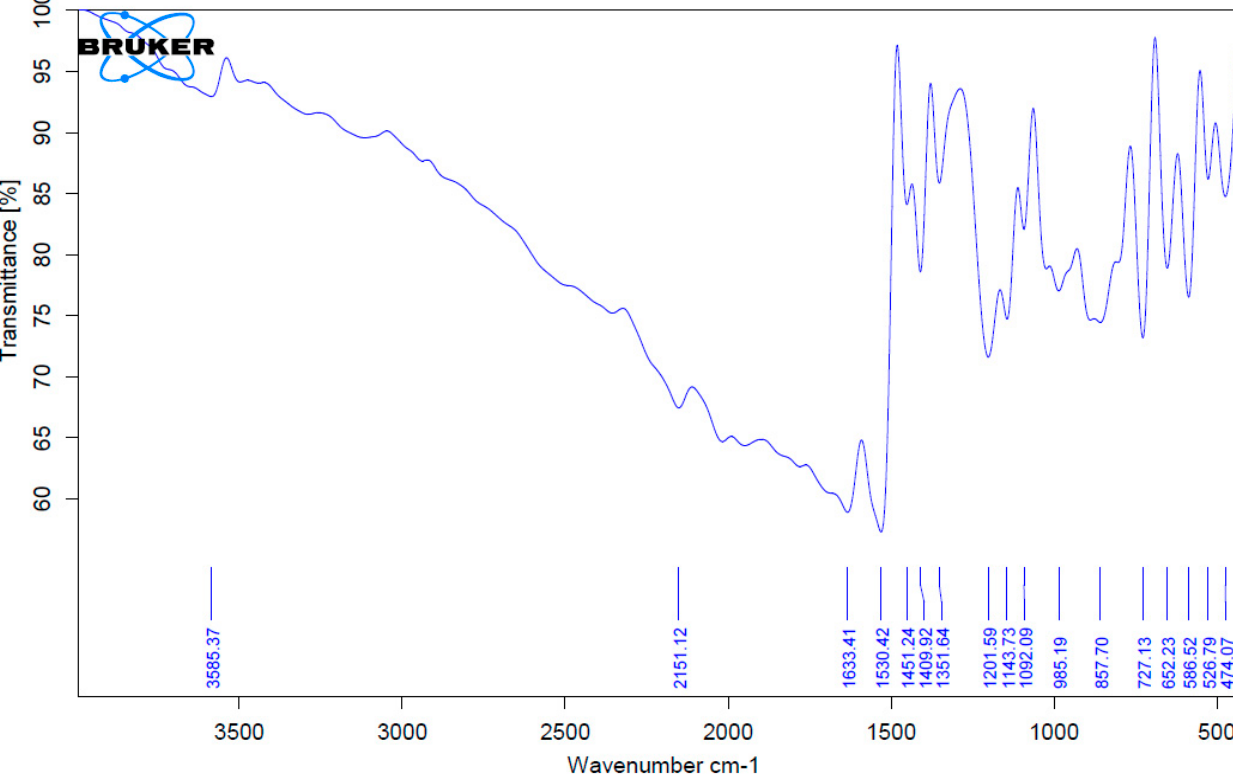
Figure 5. FTIR spectra of copper(II)-bis( N -methyl- N -phenyl dithiocarbamate) complex.